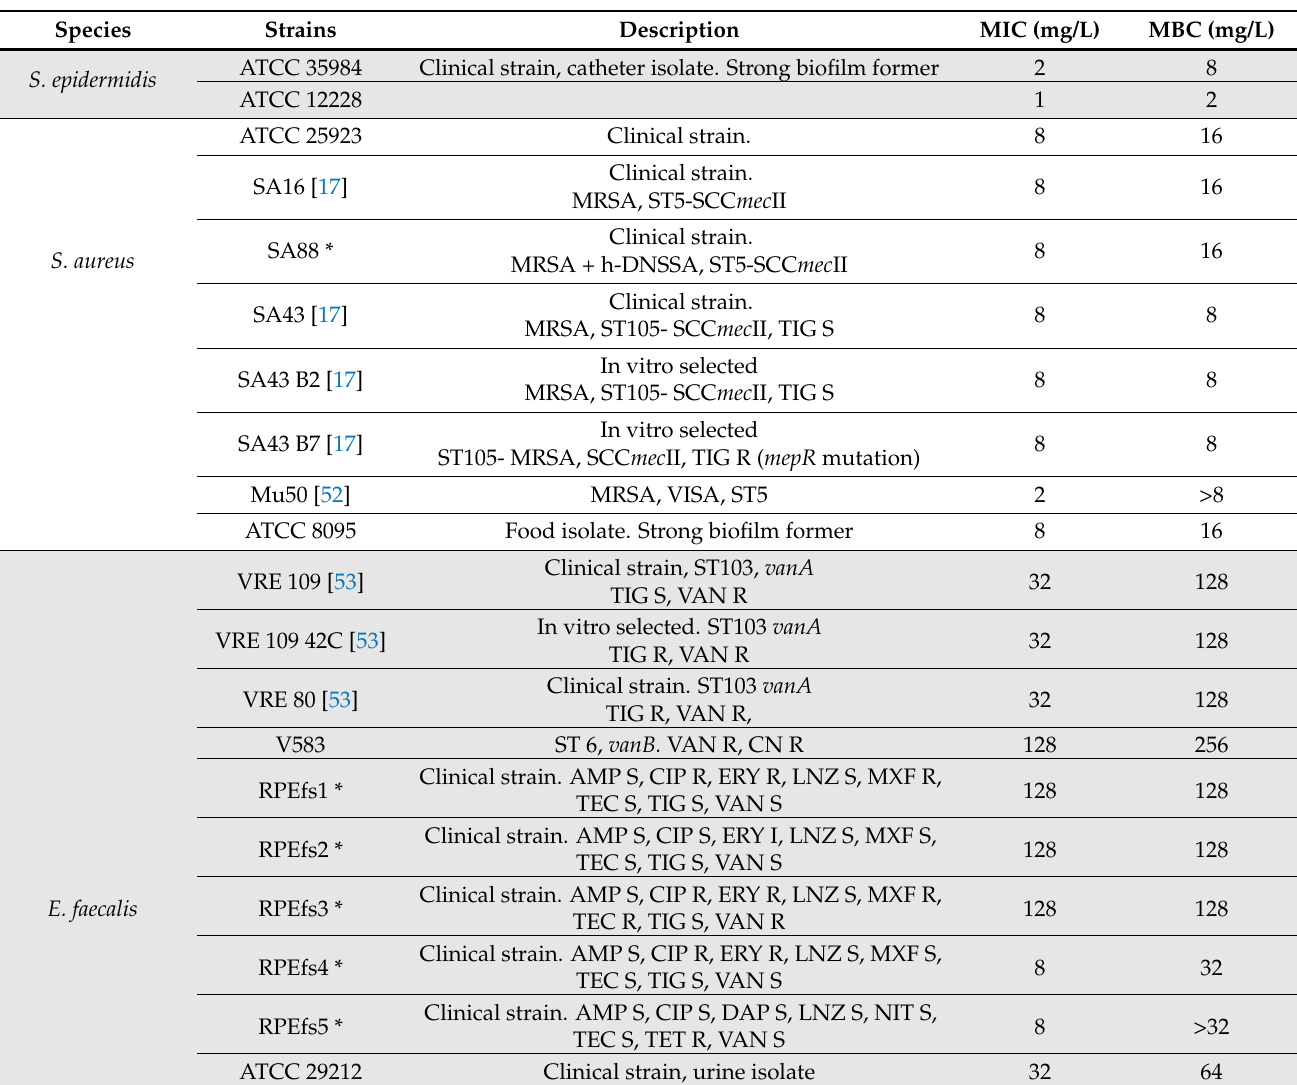
Table A1. MIC and MBC of Pln149-PEP20 against Gram-positive